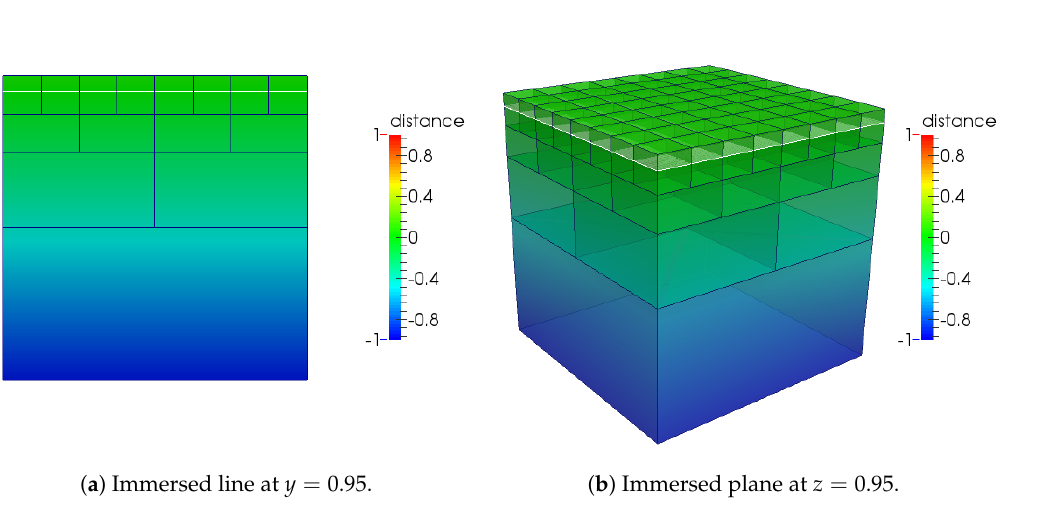
Figure 5. kd-tree subdivision of a unit cell in the presence of ( a ) a 2D immersed line and ( b ) a 3D immersed plane. The maximum level is three in both examples. The domain color represents a signed distance to the immersed boundary. Table 3. Comparison of the kd-tree and quad/oct-tree subdivision in the presence of a hyper-planar boundary as shown in Figure